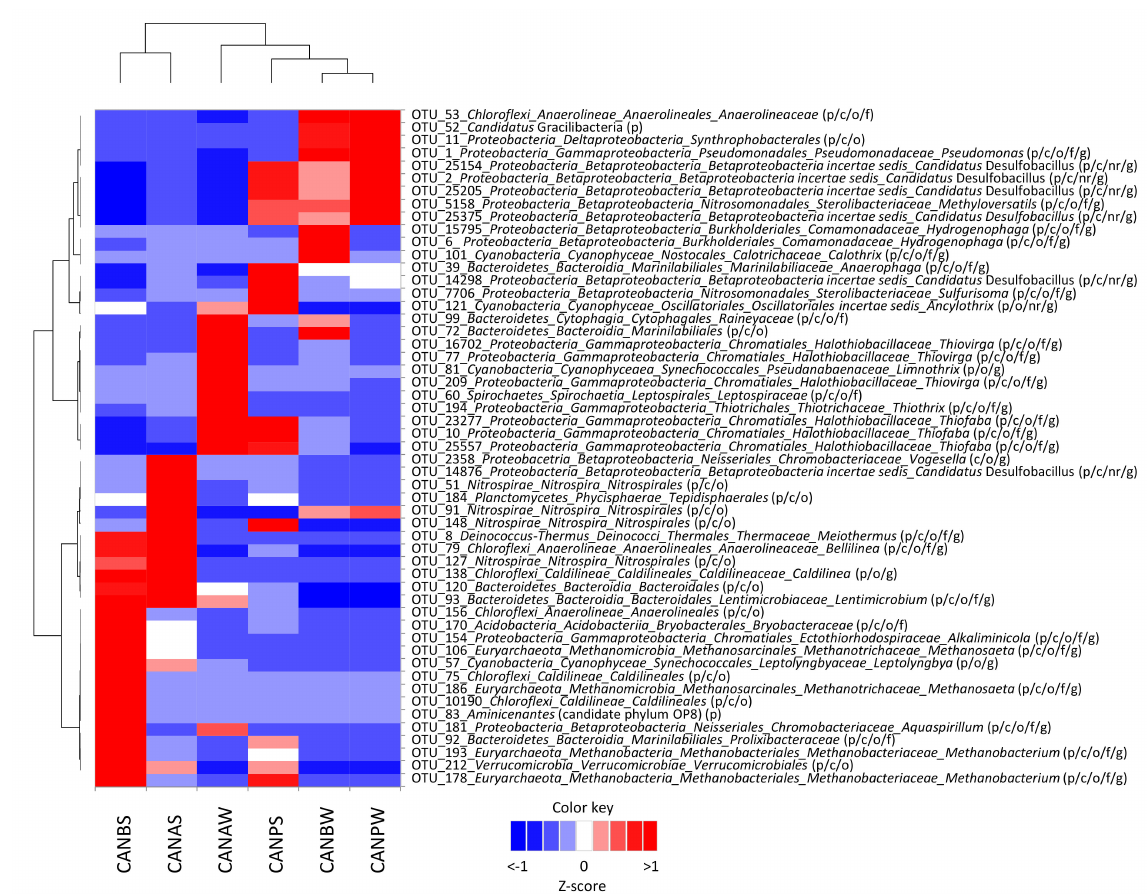
Figure 4. Heat map visualizing the Z-score distribution of the relative abundance of the dominant OTUs (>1% on average) and their respective taxonomic affiliations (from phylum to the less inclusive rank that can be attributed with certainty) in the waters and sediment samples along the water outflow of La Crouen spring (New Caledonia). The taxonomic ranks related to OTUs are in brackets. The letters p, c, o, f, g, and nr correspond to phylum, class, order, family, genus, and no rank, respectively. Abundance data used are averages of duplicate samples per sites. CANB is the source bathtub, CANP is the outlet of a pipe below the source and CANA is the small pool below CANP before its entry into the river. W and S mean Water and Sediment, respectively. Details on taxonomic affiliation of each dominant OTUs, with identity percentage with closest cultivated strains, are given in Tables S2 and